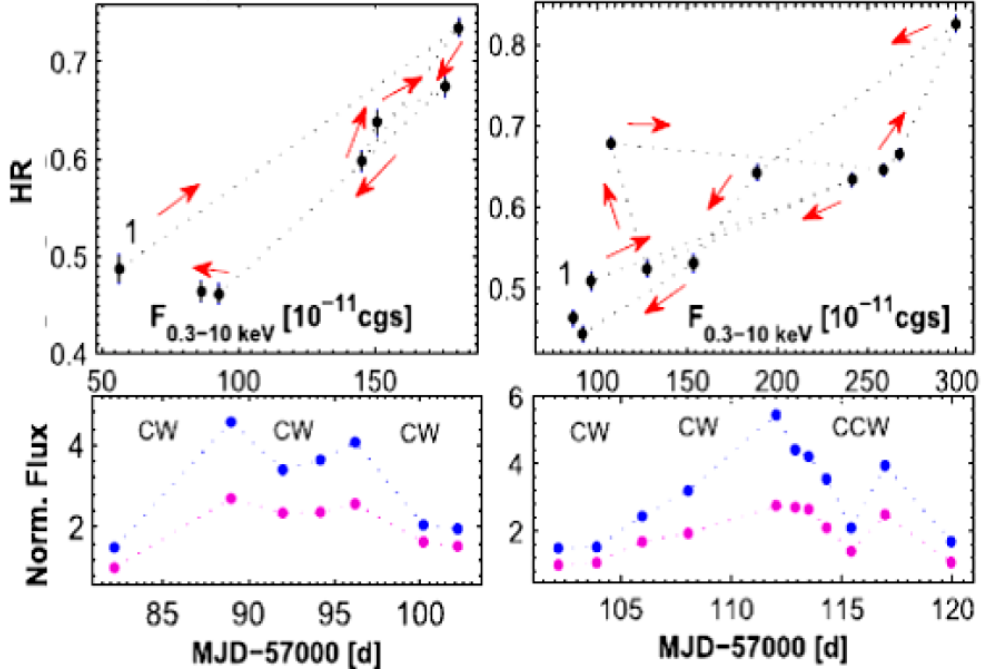
Figure 3. The hardness ratio (HR)-flux planes for the Swift-XRT observations of Mrk 421 in February 2015, along with the normalized soft 0.3–2 keV (magenta points) and hard 2–10 keV (blue points) fluxes plotted as a function of time (reproduced from Reference [27]). The light curves for hard fluxes are shifted arbitrarily for a better resolution. In each panel, the start point is denoted by “1”. The acronym “cgs” stands for erg cm − 2 s − 1 .